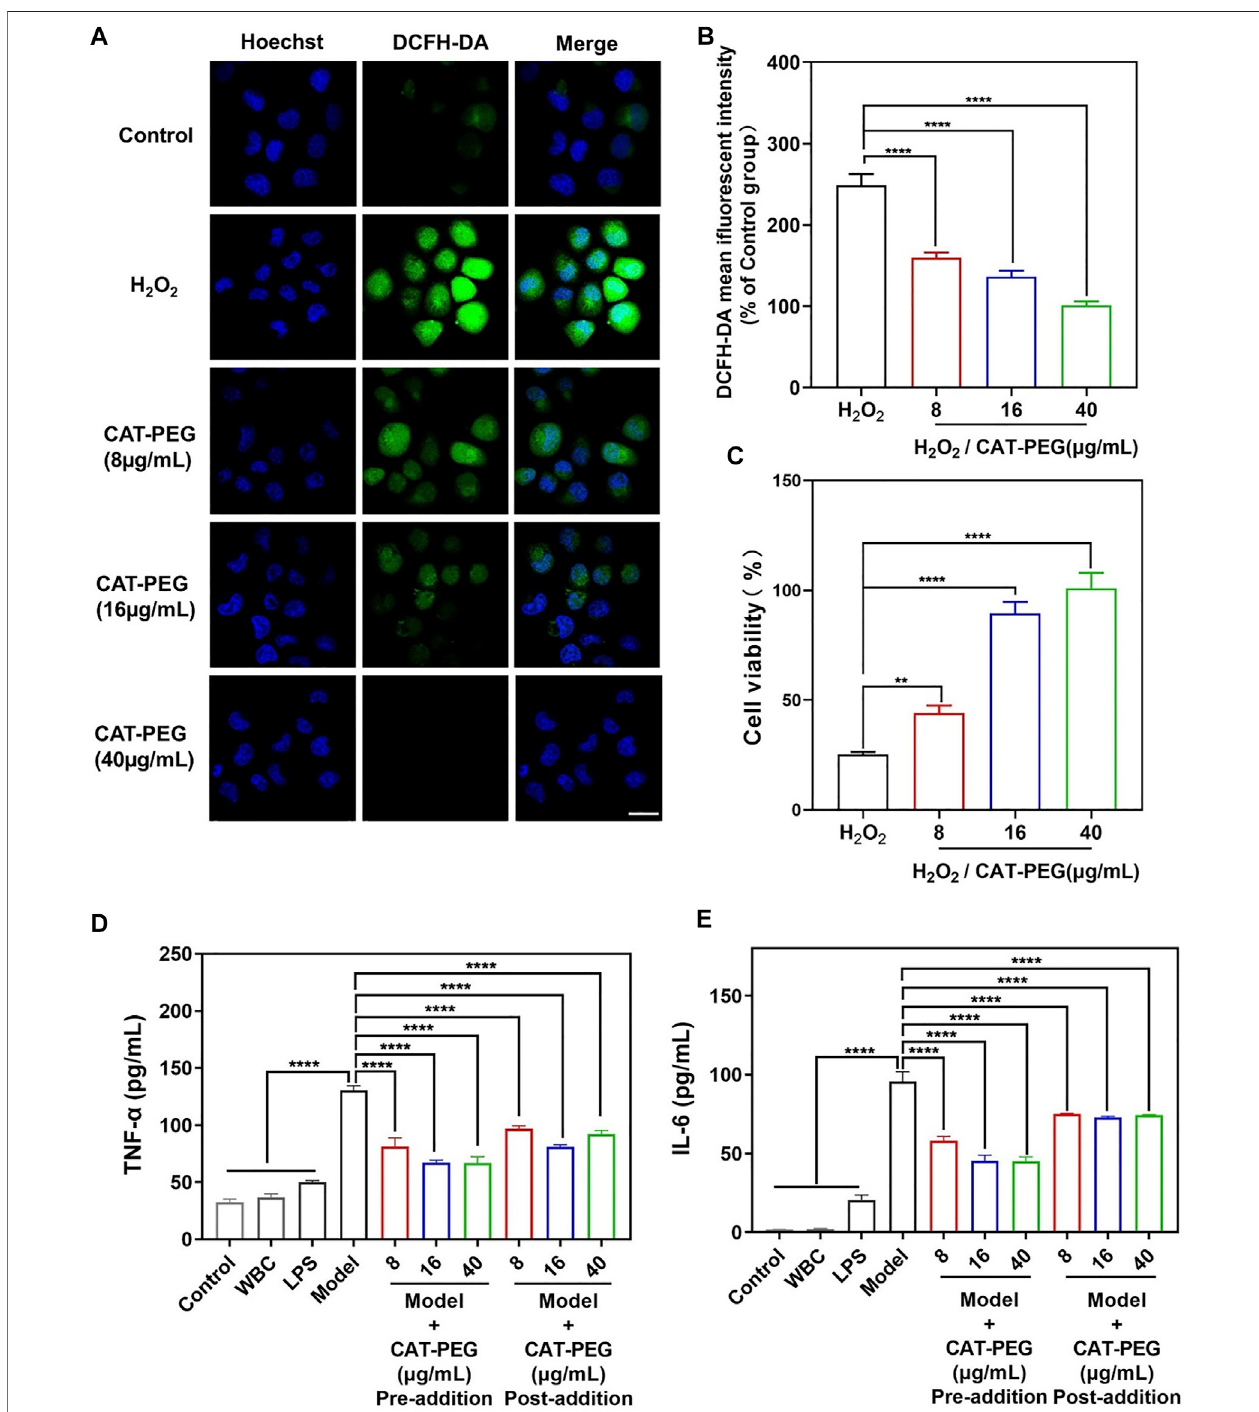
FIGURE 2 | The ability of CAT-PEG to reduce ROS level, prevent cell injury and to regulate the production of in fl ammatory factors. (A) Fluorescence images of HPAEpi cells after incubation with CAT-PEG for 12 h followed by adding 1 mM H 2 O 2 and 10 μ M DCFH-DA and incubating for 30 min (green: ROS, blue: nuclei). Scale bar: 50 μ m. (B) Relative fl uorescent intensityofDCFH-DA inthe HPAEpi cellsafter incubation withCAT-PEG for12 h followed byadding 1 mM H 2 O 2 and10 μ MDCFH- DA and incubating for30 min (%ofControlgroup). (C) Cellviability oftheHPAEpicellswith8 μ g/ml,16 μ g/ml,40 μ g/mlofCAT-PEG for12 h, followed byaddition of H 2 O 2 (1 mM) and culturing for 24 h (D, E) The concentration of TNF- α (D) and IL-6 (E) in the media of HPAEpi cells cultured with WBC, LPS, and different concentrationsofCAT-PEG. InthePre-additionstudy,HPAEpicellswere fi rstculturedwithdifferentconcentrationsofCAT-PEGfor12h,followedbyaddingLPS(1 μ g/ ml) and culturing for 24 h. In the Post-addition study, HPAEpi cells were cultured with 1 μ g/ml LPS for 24 h, followed by culturing in fresh media containing different concentrations of CAT-PEG for 12 h n (cid:2) 3. Data represent means ± s.e.m., p value: *p ＜ 0.05, **p ＜ 0.01, ***p ＜ 0.001 and ****p ＜ 0.0001. ns means not signi fi cant.